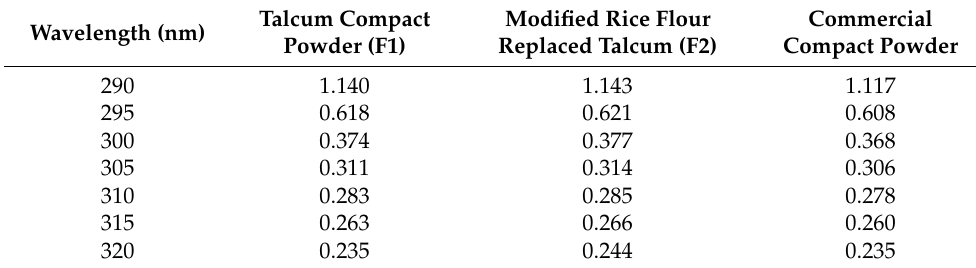
Table 3. Absorbance of each compact powders used in the calculation of SPF